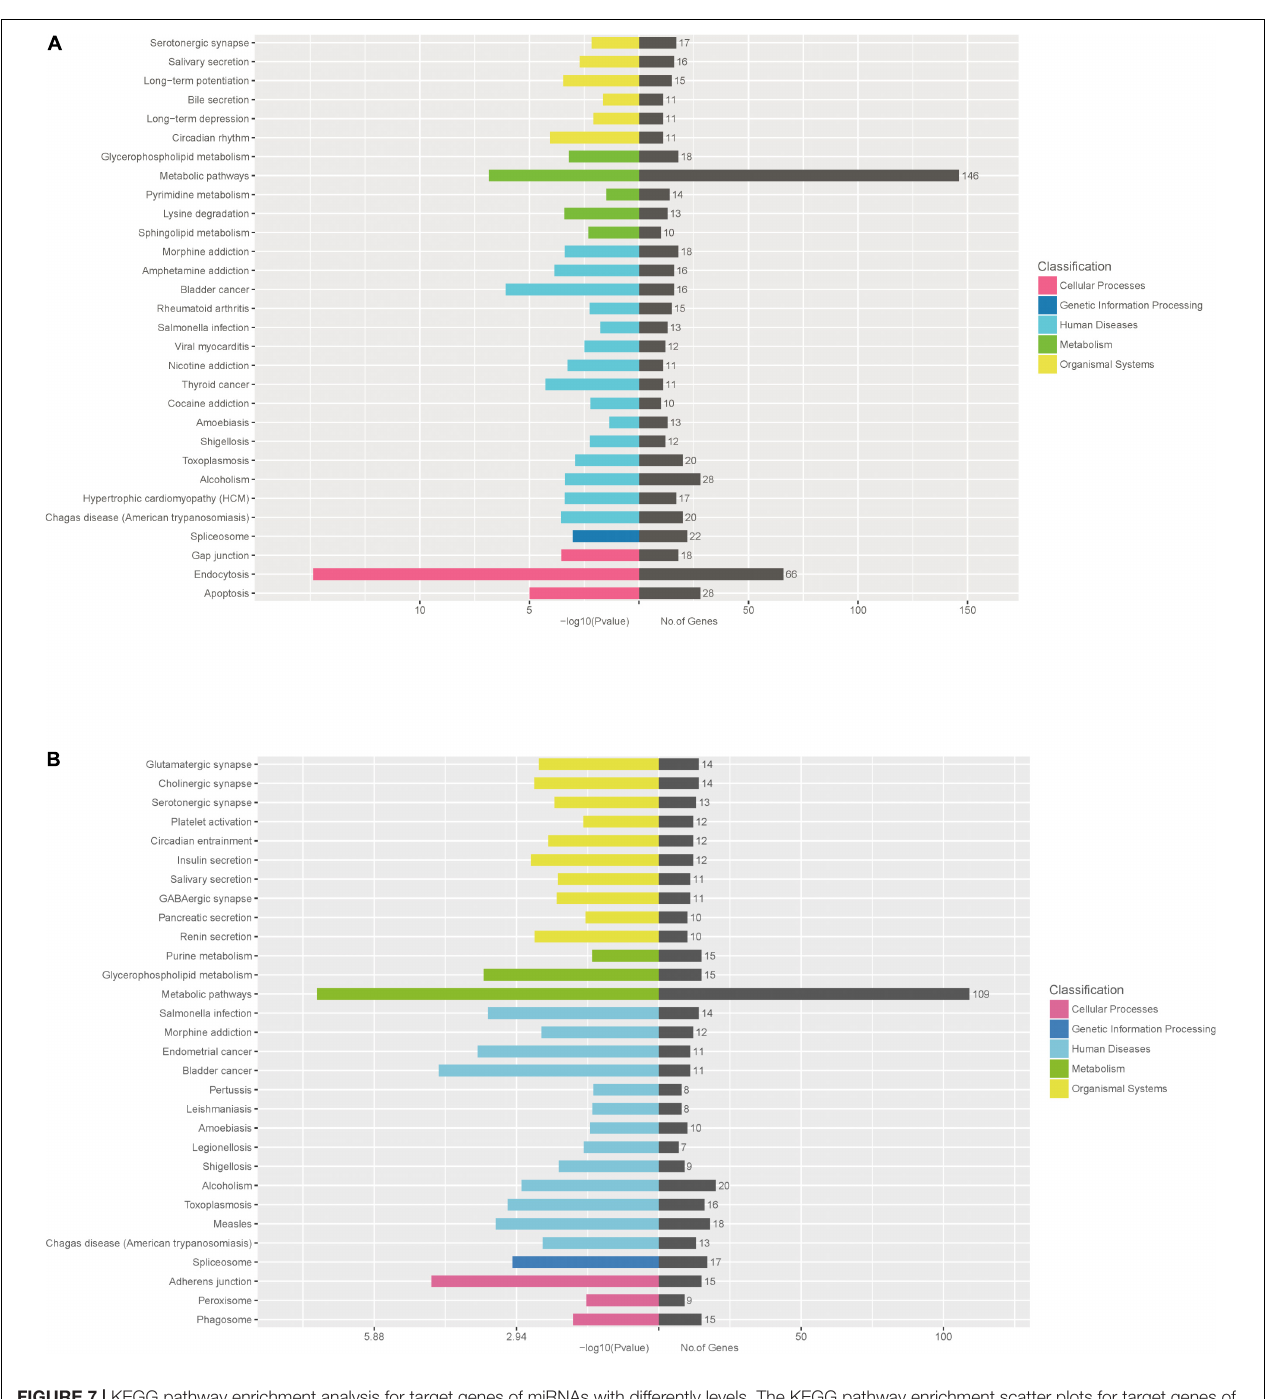
FIGURE 7 | KEGG pathway enrichment analysis for target genes of miRNAs with differently levels. The KEGG pathway enrichment scatter plots for target genes of up-regulated miRNAs (A) and down-regulated miRNAs (B) are shown.